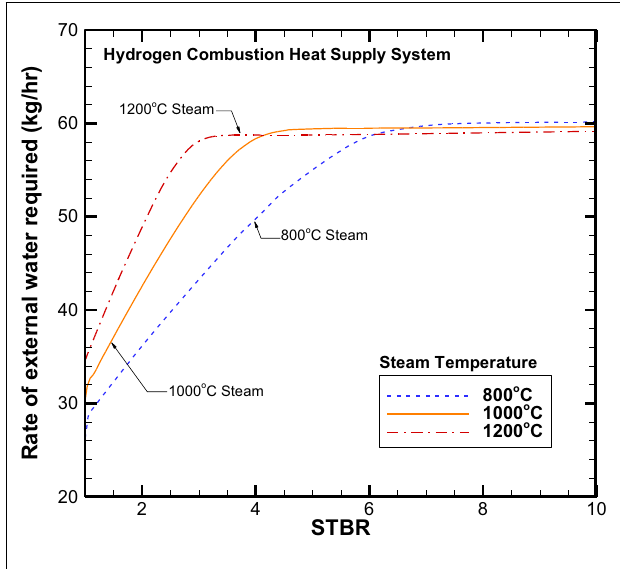
FIGURE 11 | Efficiencies for concept system I as a function of STBR